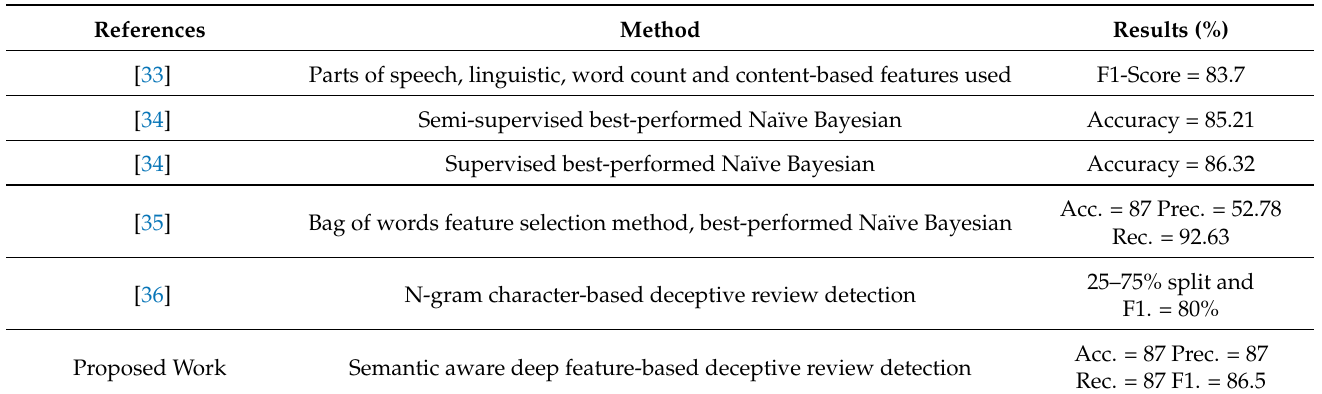
Table 6. Comparison with state-of-the-art